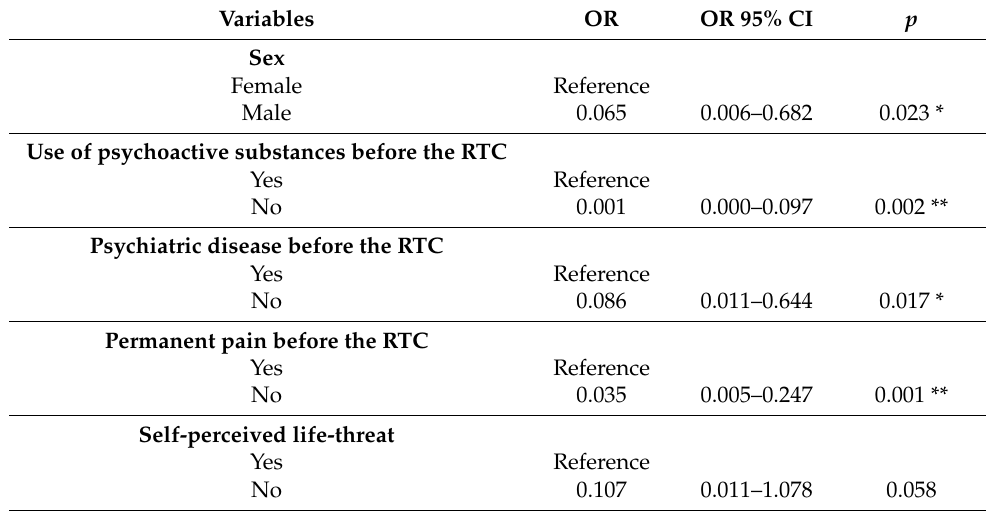
Table 5. The multivariable regression model for anxiety symptoms at 1-month follow-up. Variables OR OR 95% CI